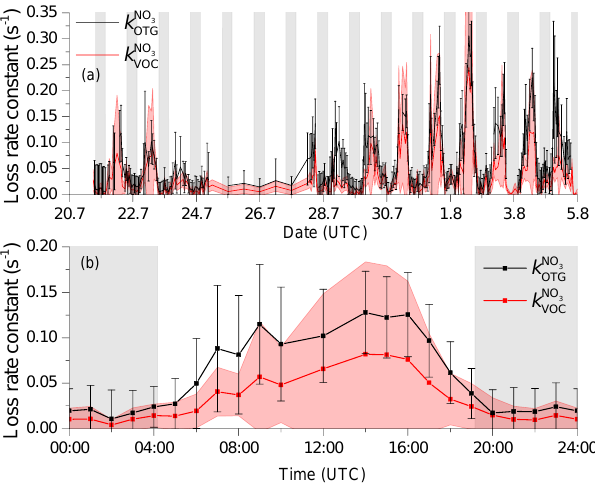
Figure 5. (a) Time series of k NO 3 and k NO 3 . The error bars on the VOC OTG k NO 3 measurements are total uncertainty calculated as described OTG by Liebmann et al. (2017). The uncertainty in k NO 3 (shaded red VOC area) is dominated by uncertainty in the mixing ratios of the VOCs. Panel (b) is a campaign-averaged diel profile of the same parame- Figure 6. NO 3 mixing ratios measured in the night from 2–3 August as well as NO 2 and O 3 (which define the NO 3 production rate). T : temperature, RH: relative humidity, WD: wind directions, WS: wind